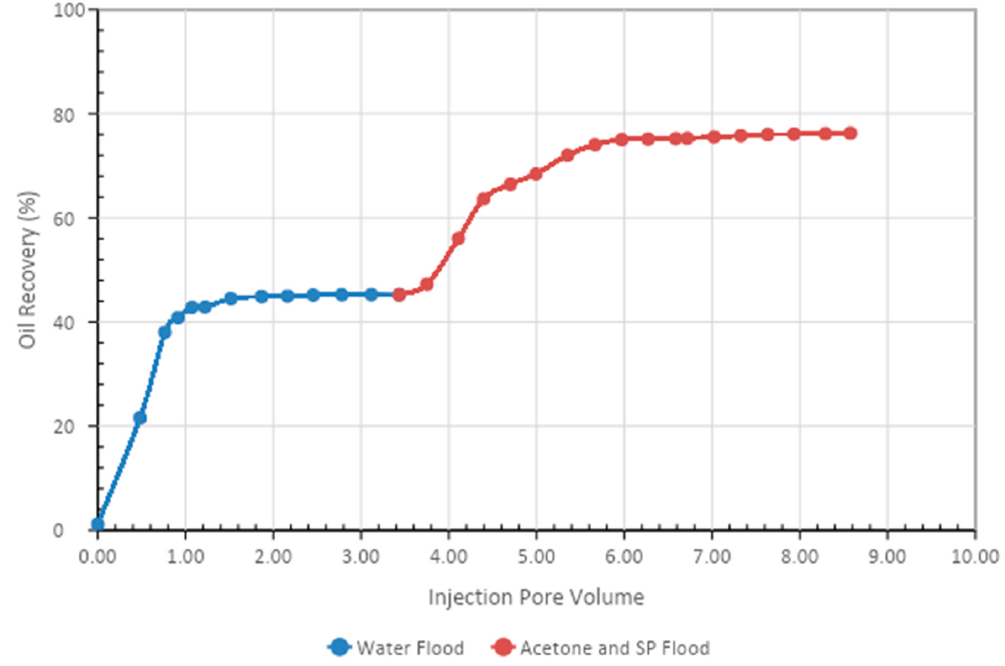
Figure 11. Total oil production from the core after the brine, acetone, and SP blend, followed by a post-flood with brine. Table 9. Flood Results for Butanone, APG 264, and Xanthan Gum Mixture.